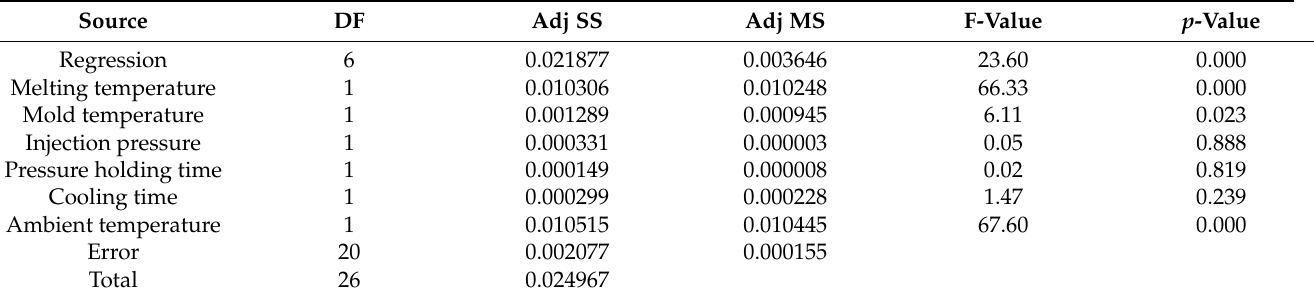
Table 6. Variance analysis.